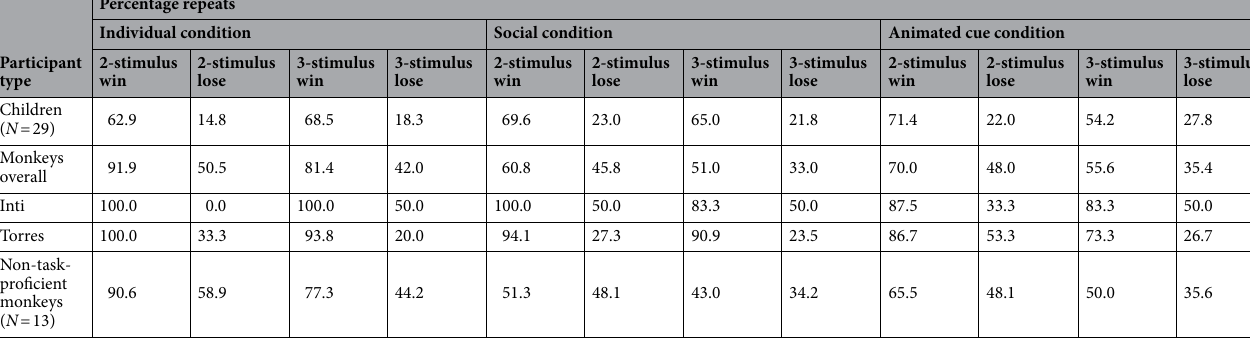
Table 1. Overall performance (percentage repeats) of children and capuchin monkeys in the various conditions. Chance performance for the repeats measure is 50.0% in 2-stimulus trials and 33.3% in 3-stimulus trials.